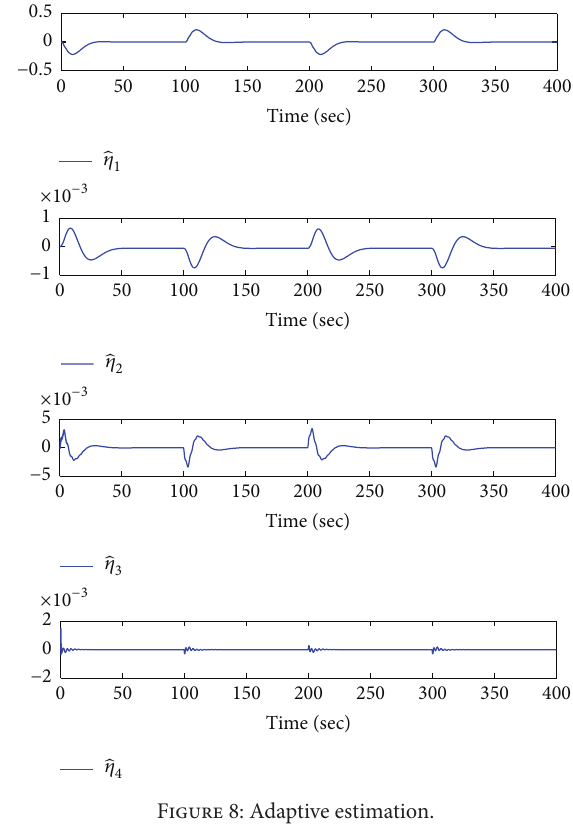
Figure 8: Adaptive